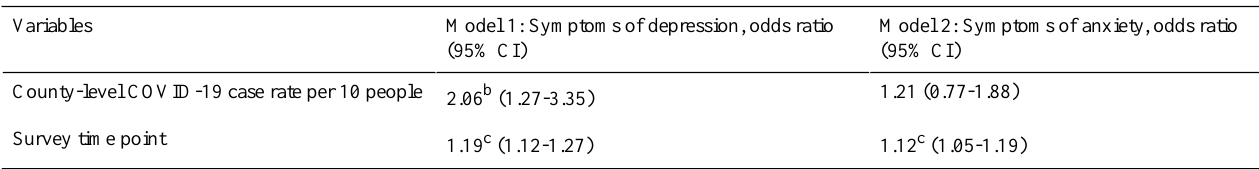
Model 2: Symptoms of anxiety, odds